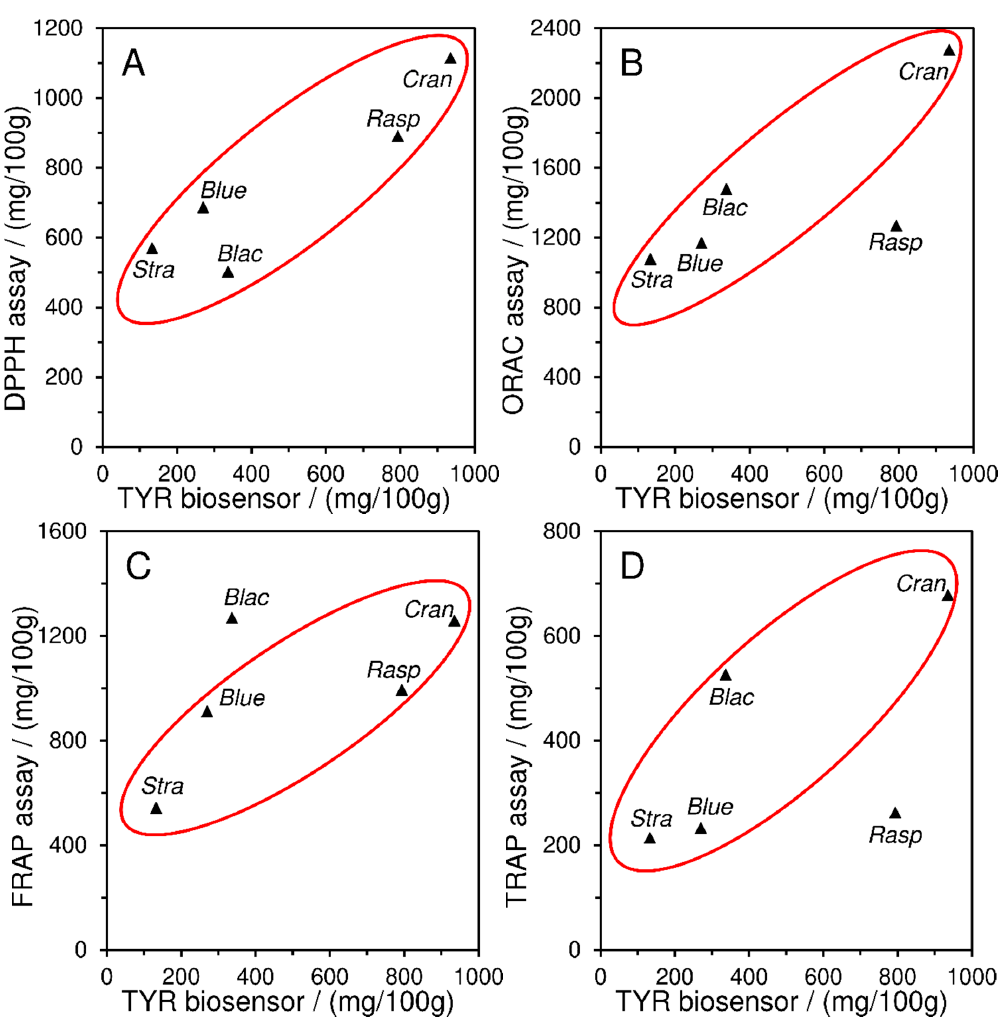
Figure 6. Comparison of TYR biosensor with other analytical assays ( A ) DPPH, ( B ) ORAC, ( C ) FRAP and ( D ) TRAP for analysis of TEAC in pulps of strawberries ( Stra ), blackberries ( Blac ), raspberries ( Rasp ), blueberries ( Blue ) and cranberries ( Cran ).